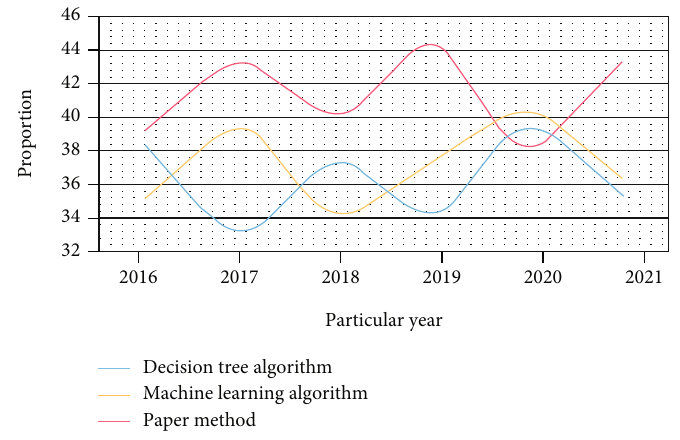
Figure 4: Number of times of live operation in distribution network of power grid